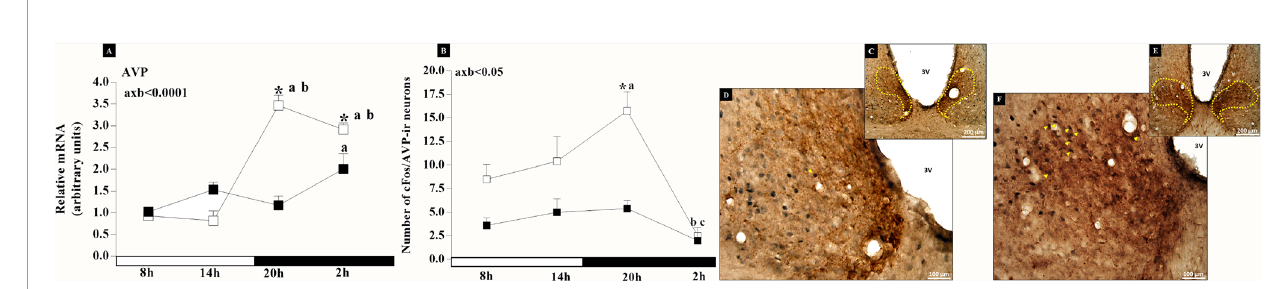
FIGURE 2 | Graphical representation of higher AVP gene expression (A) and AVP neuronal activity (B) observed in rats with irregular cycle (IC group) in persistent diestrus ( □ ) compared to adult rats with regular estrous cycle (RC) on diestrus day ( ■ ). The mean ± SEM number of cFos/AVP-ir neurons are shown on the graph. * p < 0.05 vs. RC at the same time interval; a vs. 08:00, b vs.14:00, and c vs. 20:00; axb = interaction of age and time. Photomicrographs of vasopressinergic neurons in the dorsomedial portion of the SCN doubly labeled with cFos (arrows) at 20:00 on diestrus day. Animal RC increased by 200× (C) and 400× (D) ; animal IC increased by 200× (E) and 400× (F) .